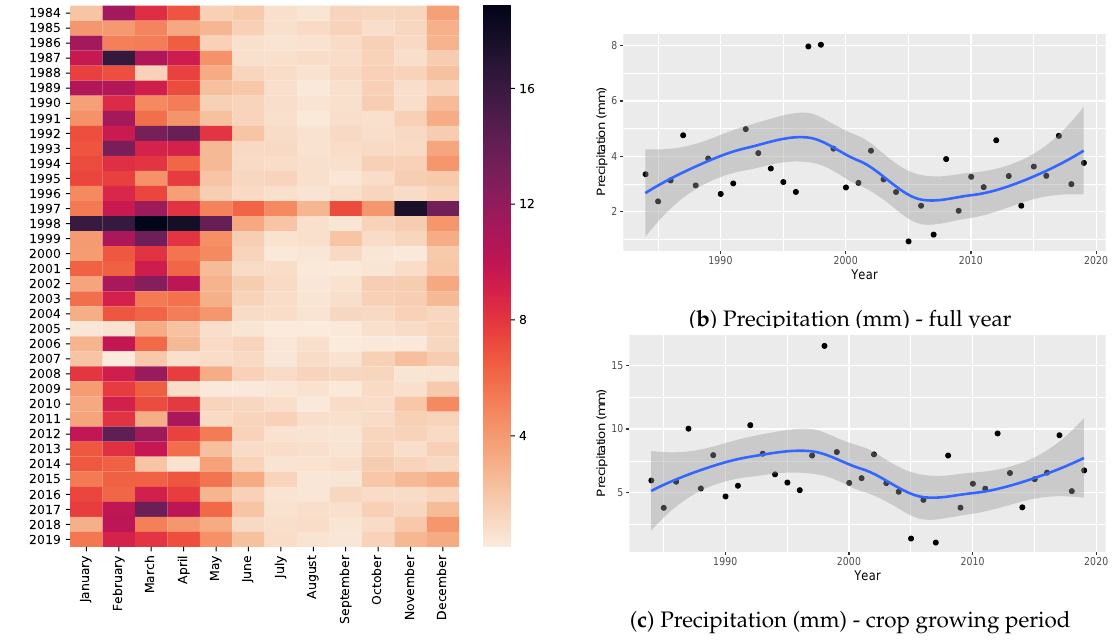
Figure A6. Time series of daily average precipitation (mm) in Los Rios from 1984 to 2019. ( a ) Heat-map of daily precipitation (mm) per each month and year. The color scale represents the precipitation in mm. ( b ) Daily precipitation averaged during the full year. ( c ) Daily precipitation averaged during the maize crop growing period in Ecuador (January–May). Each dot represents one record, the blue line shows the smoothed time series and the shaded area represents the 95% confidence interval.